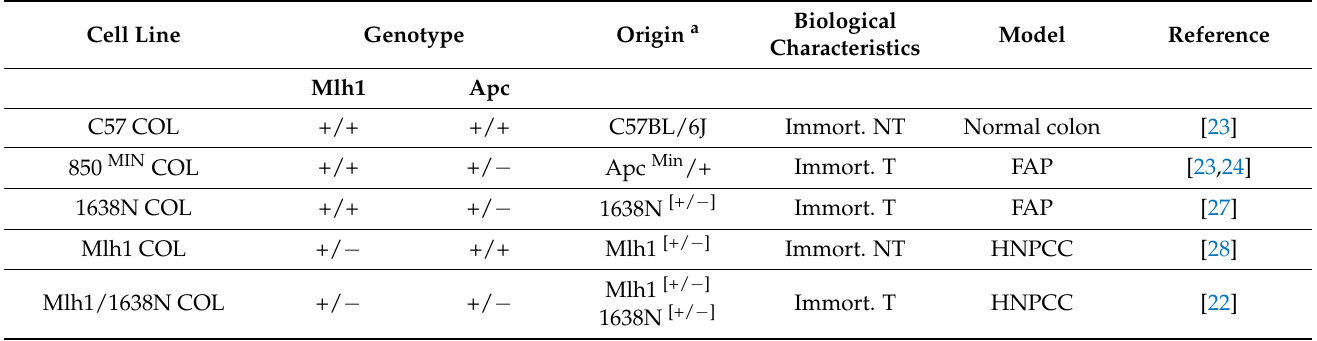
Table 1. Cellular models for colonic epithelial